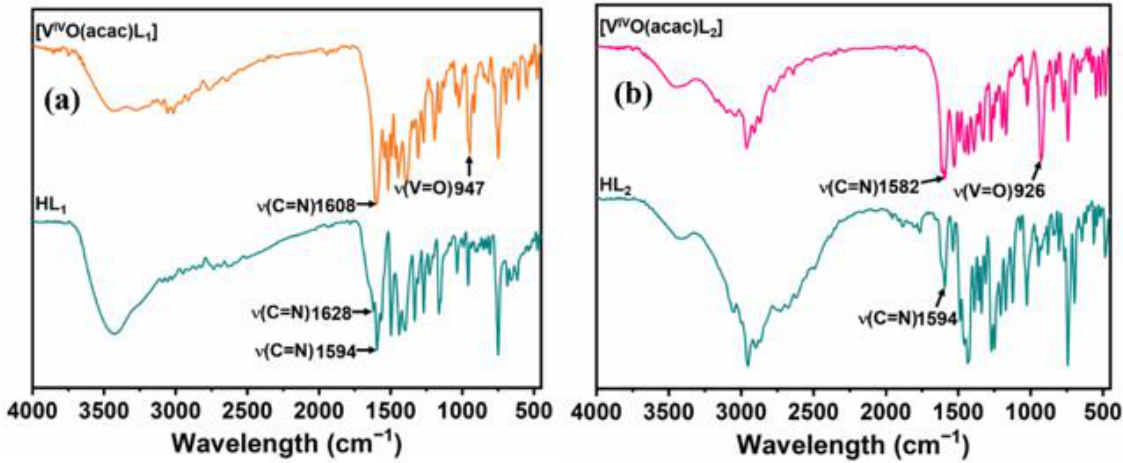
Figure 8. FT-IR spectra of ( a ) HL 1 and [V IV O(acac)L 1 ], and ( b ) HL 2 and [V IV O(acac)L 2 ].